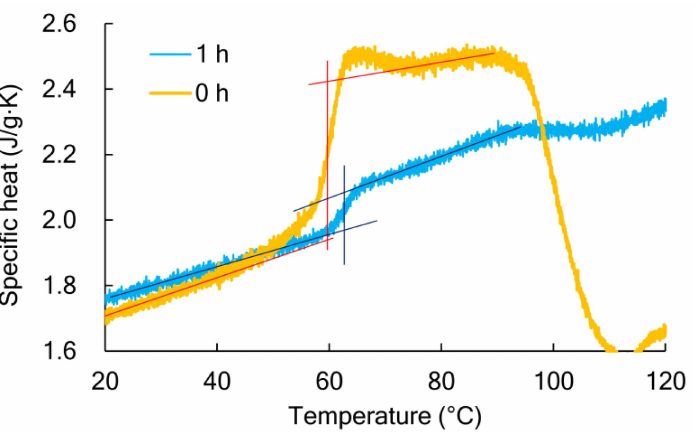
Figure 2. Comparison of specific heat between the amorphous PLA (0 h) and annealed PLA at 70 °C and 95% RH (1 h).